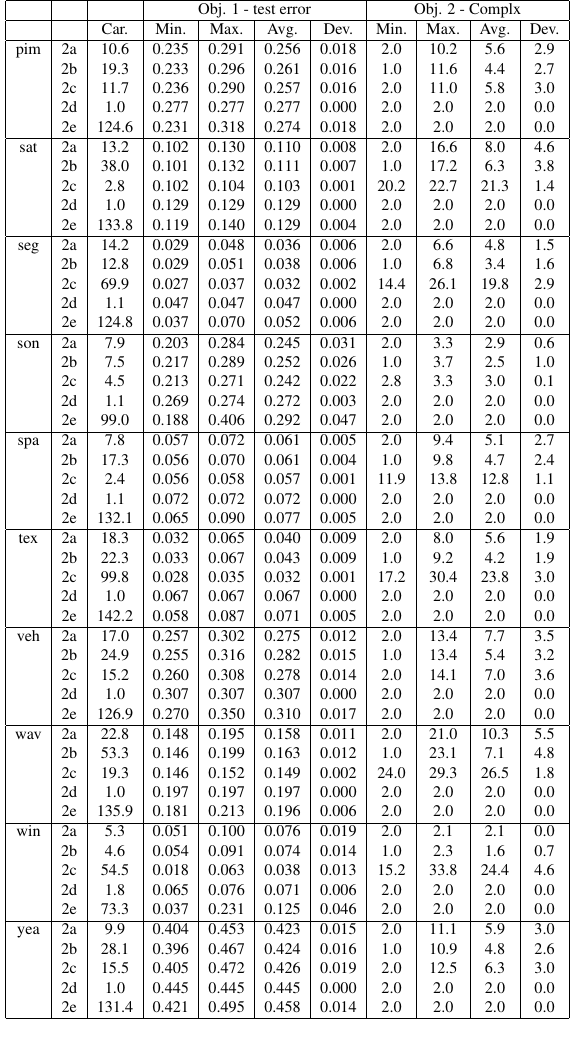
Table 7. Statistics of the Pareto front approximations with the global learning objectives.(cont.) Obj. 1 - test error Obj. 2 - Complx Car.